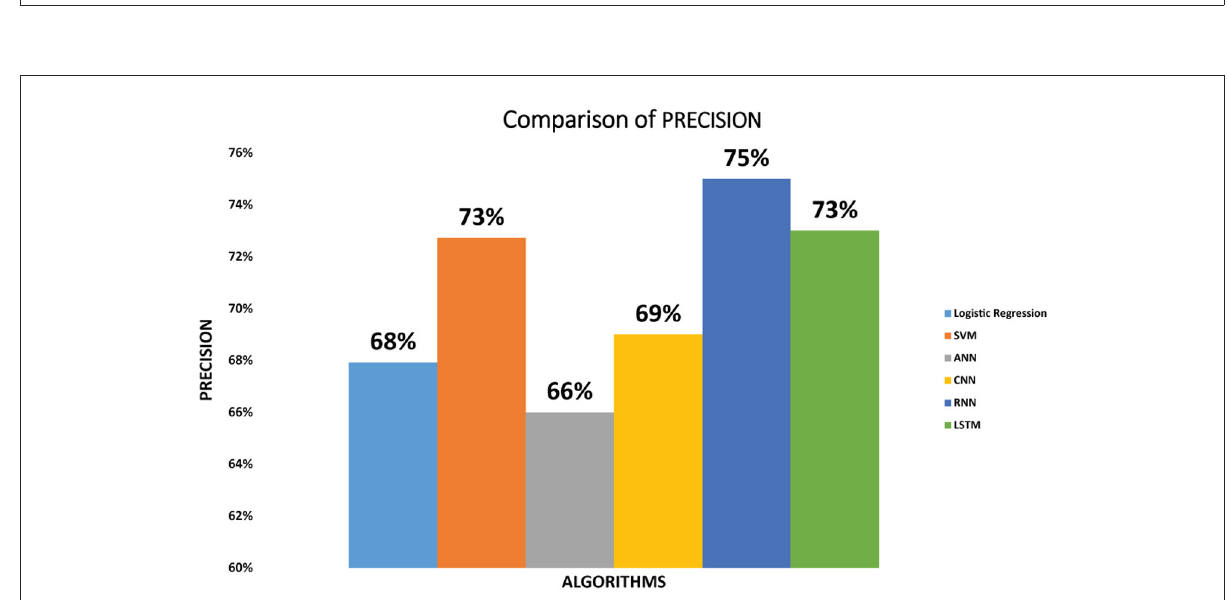
FIGURE3 Comparison of precision for logistic regression, SVM, ANN, CNN, RNN, and LSTM.